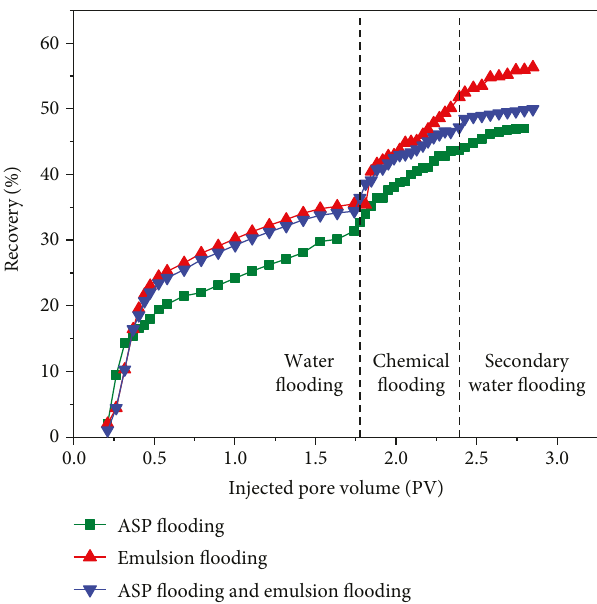
Figure 15: Total recovery variation curve of di ff erent chemical fl